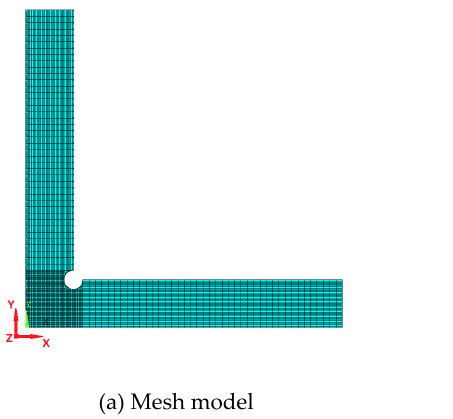
Figure 6. Horizontal stress distribution in specimens type A, B, C, and D ( n = 0, σ (cid:2868) = 200 MPa).